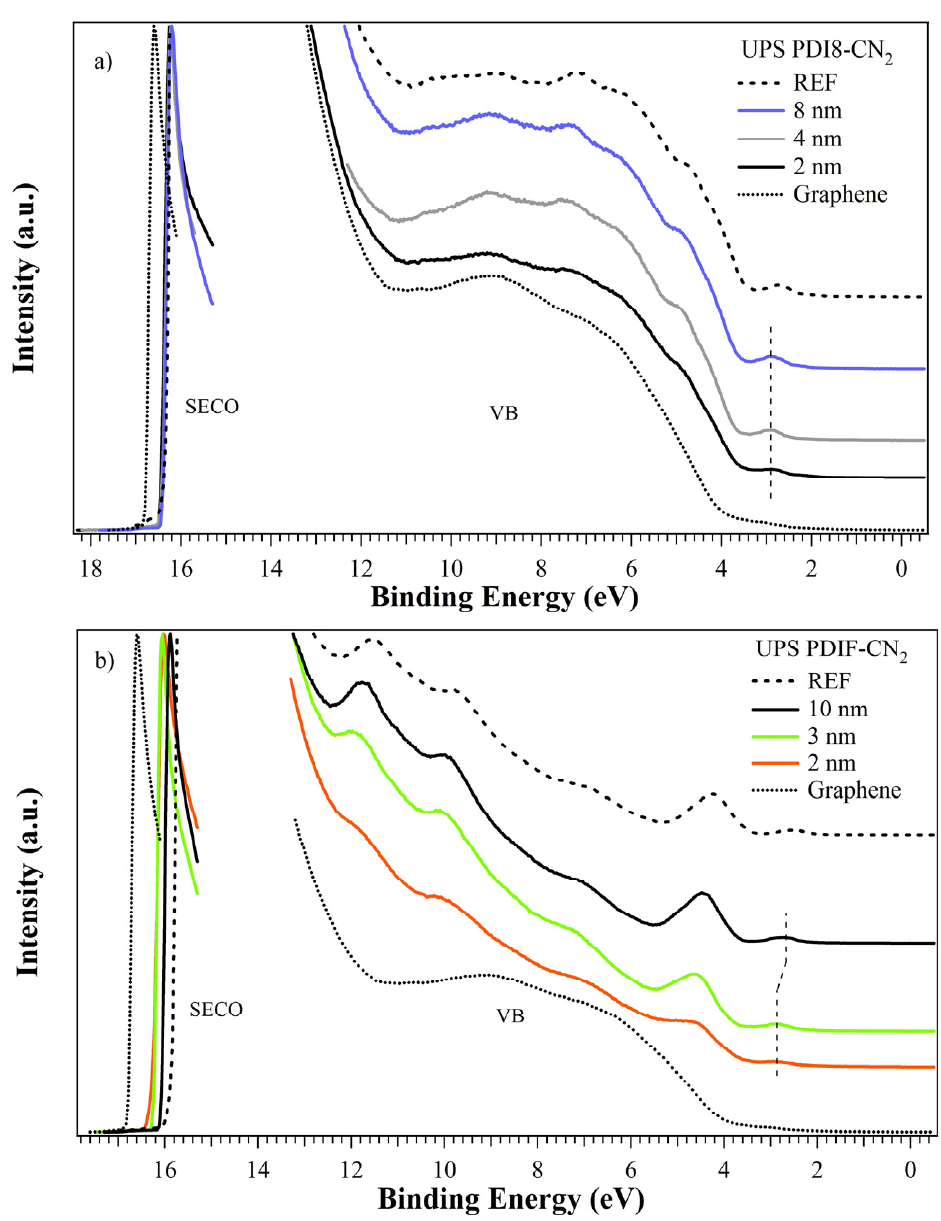
Figure 4. UPS spectra of the ( a ) PDI8-CN2 and ( b ) PDIF-CN2 thin films with different nominal thicknesses on CVD-graphene. Spectra for the thick film and the bare graphene are shown for reference.